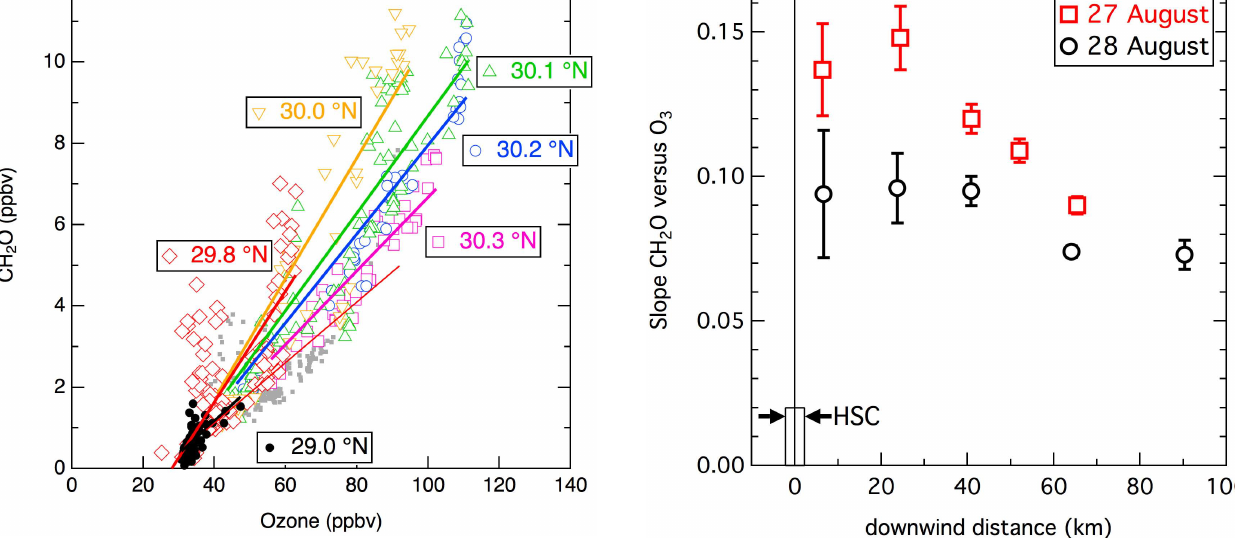
Fig. 3. Dependence of the slope with 95% confidence limits of the CH 2 O versus O 3 relationship as a function of downwind distance from HSC. The 27 August 2000 data are from the linear regressions illustrated in Fig. 2; the 28 August 2000 data are from a similar analysis of a second flight conducted under similar meteorological conditions. The bar with arrows indicates the location and approx- imate width of the HSC industrial region. The farthest downwind transect corresponds to about 6h transport